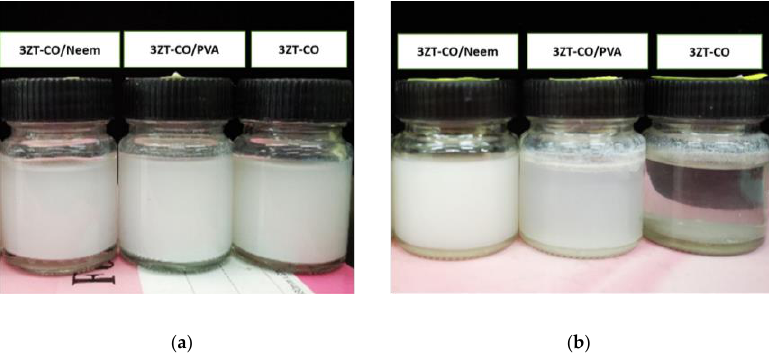
Figure 7. Compatibility test: ( a ) Various nanoparticles dispersed in 1,4-dichlorobenzene and ( b ) 3ZT-CO aggregates in 1,4-dichlorobenzene after 3 months.